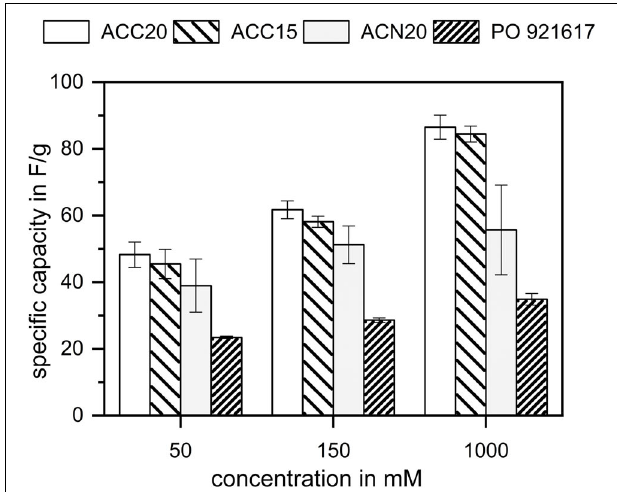
FIGURE 5 | Specific capacitance values of the investigated carbon materials estimated by the EIS measurements at low frequencies. For each electrolyte concentration investigated, the specific capacitances follow the trend of the specific surface areas determined by BET. In case of the materials with the highest specific surfaces, the relationship is not proportional, indicating that the largest pores of the material ACC20 do not fully contribute to the specific